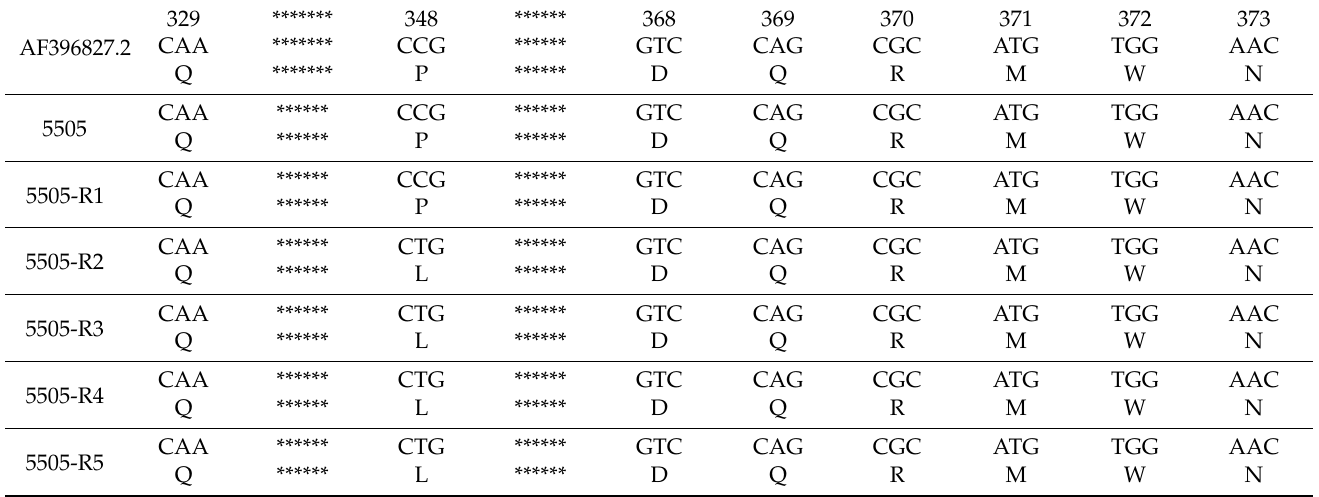
Table 2. Comparison of Bos1 gene fragments and amino acids between B. cinerea sensitive and resistant